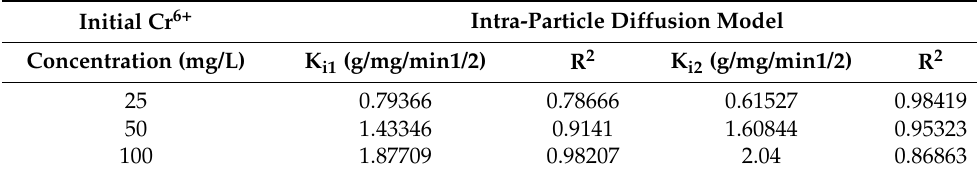
Table 5. Fitting constant values of intra-particle diffusion model. Initial Cr 6+